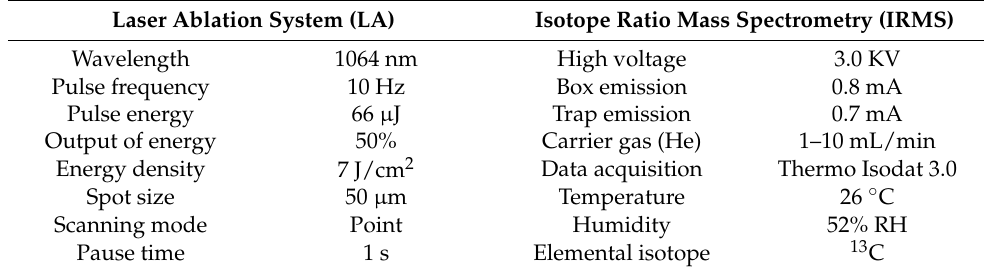
Table 1. Measurement parameters of LA-IRMS.